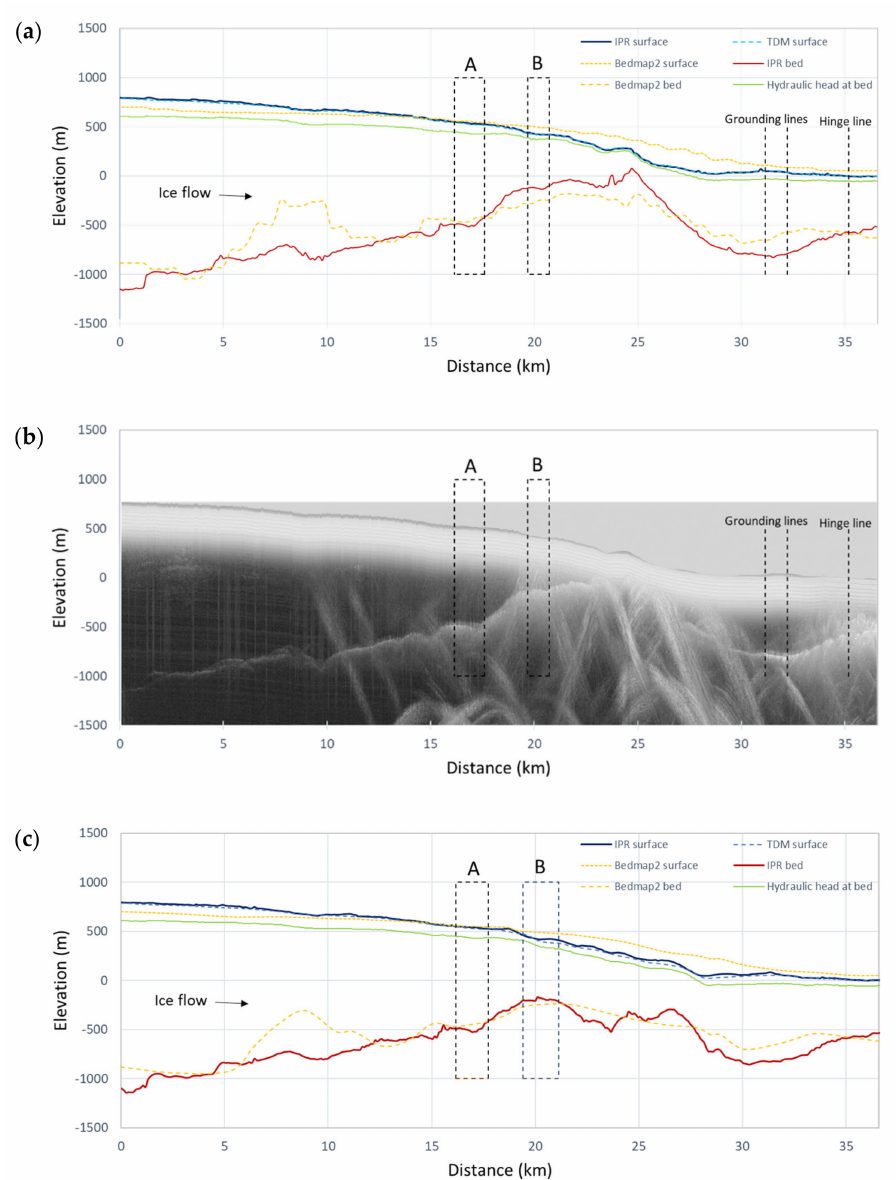
Figure 7. Ice surface and bed profiles of Campbell Glacier: ( a ) along the survey line; ( b ) the corre- sponding radargram; ( c ) along the glacier valley line. Note the similarity of surface profiles between IPR and TanDEM-X DEM, and the better resolution of IPR-derived bed topography than Bedmap2. IRP-derived bed topography in ( c ) along the glacier valley indicates that A is relatively flat along the bed hill, while B is on top of the hill. A has high possibility of a subglacial water reservoir due to the bright radar signal in ( b ) and the flat hydraulic head both in ( a , c ). Note the two profiles overlap each other in A while they deviate in